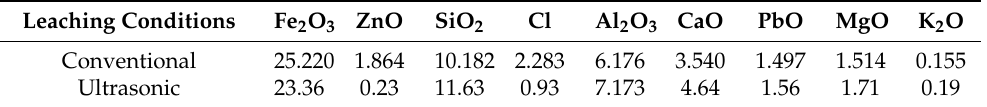
Table 3. Chemical multielement analysis of leaching residue (%).